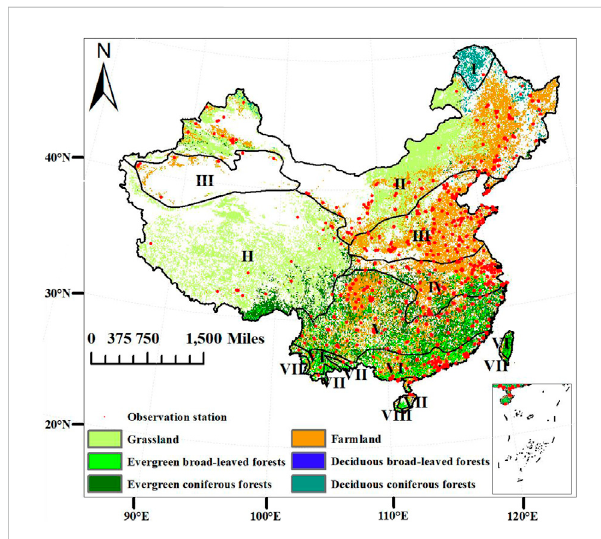
FIGURE 1 Spatial coverage map of six major ecosystem types (from China Cover 2010) and spatial distribution map of O 3 ground observation stations in China, 2010 (from the China Air Quality Real-time Publishing Platform of China Environmental Monitoring Station, http://www.cnemc.cn/sssj/), Climate zoning data (from Resource and Enviroment Science andData Center,https://www.resdc.cn/Datalist1.